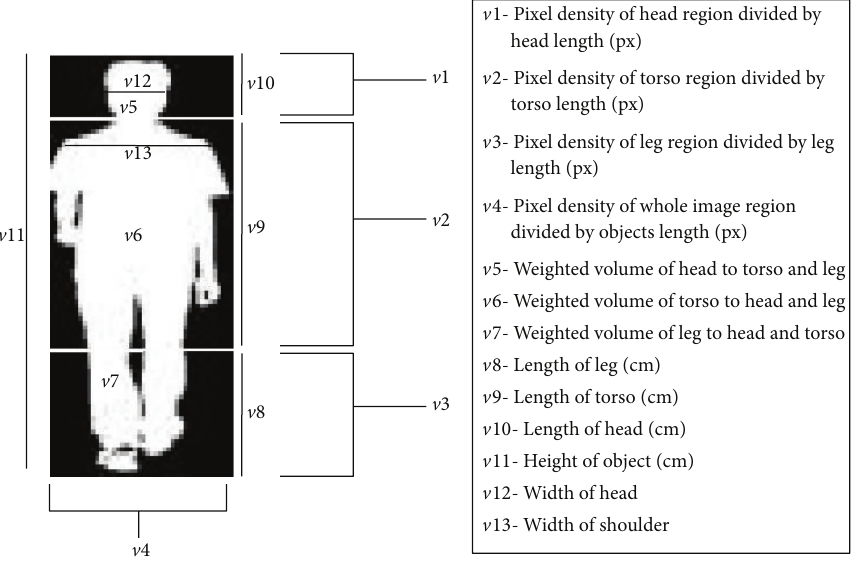
Figure 8: The feature set for weight